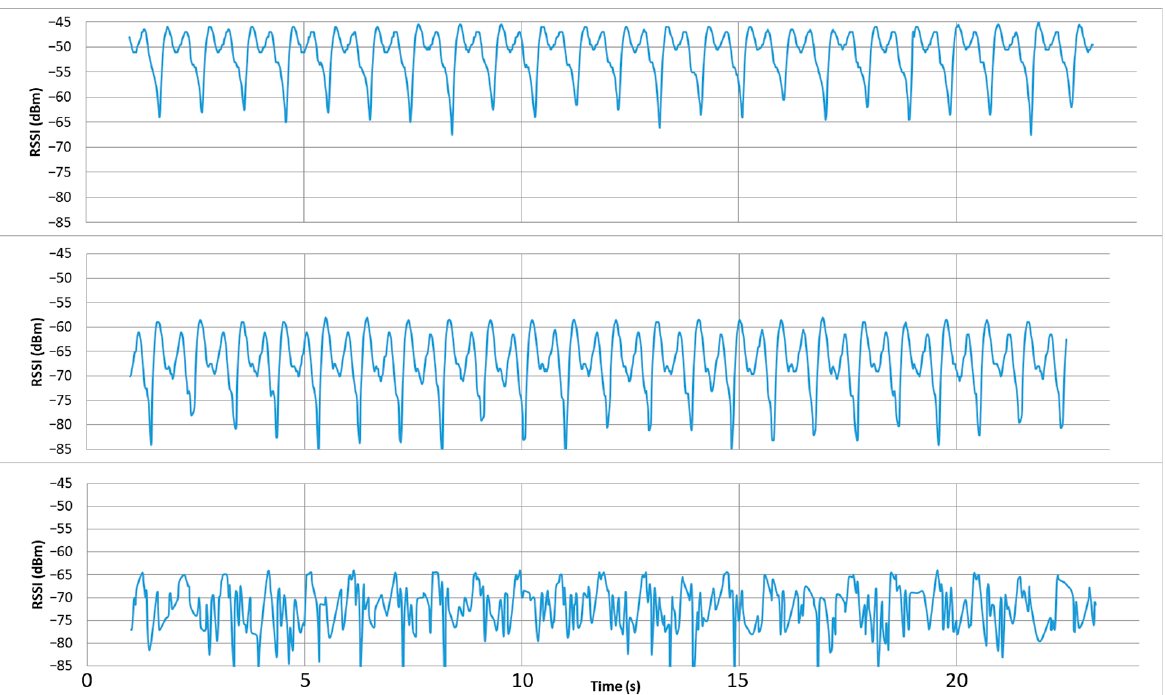
Figure 11. RSSI variation with time in the cycling scenario for 0 dBm of transmit power: ( top ) 433 MHz, ( middle ) 868 MHz, ( bottom ) 2.4 GHz.